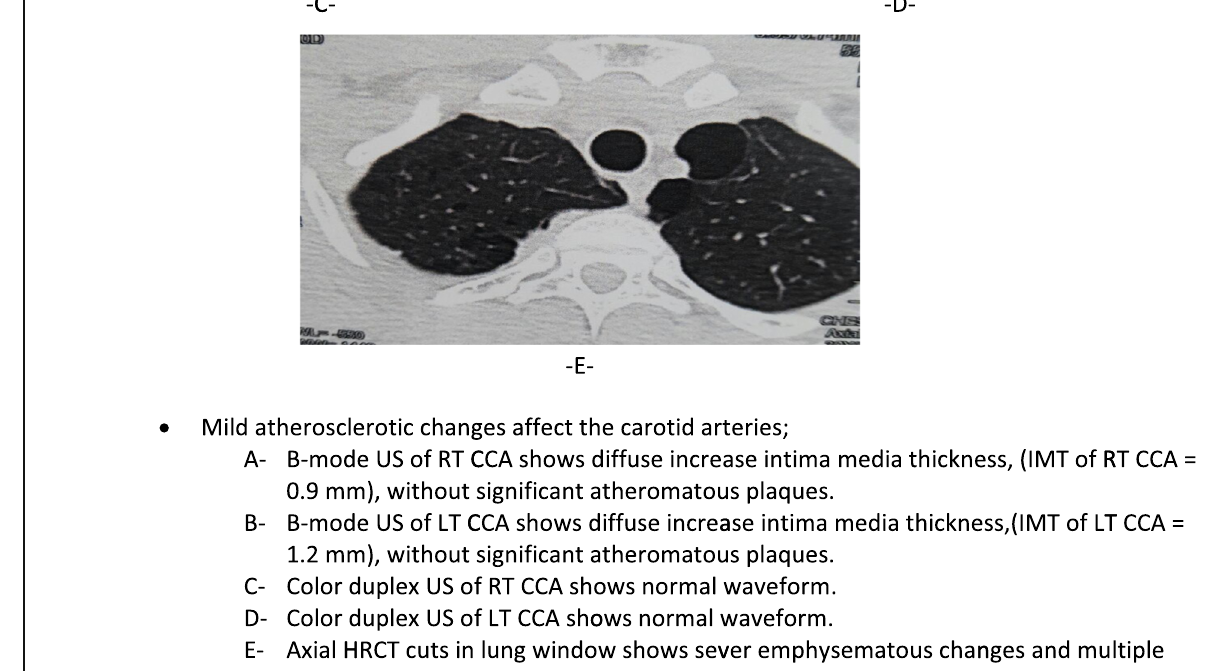
Fig. 3 A case of severe emphysematous changes and mild carotid arteries atherosclerotic changes. Mild atherosclerotic changes affect the carotid